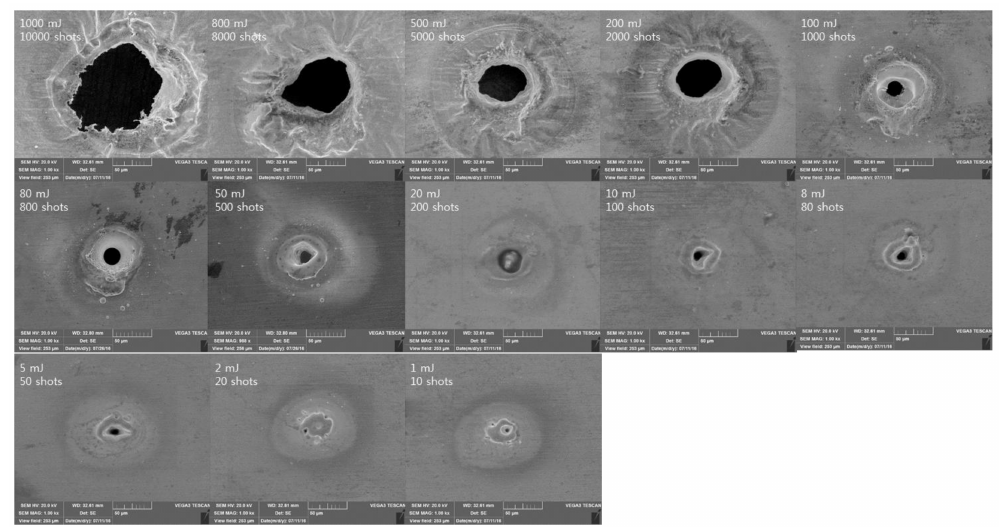
Figure 13. SEM images of laser ablation with ∆ t = 8